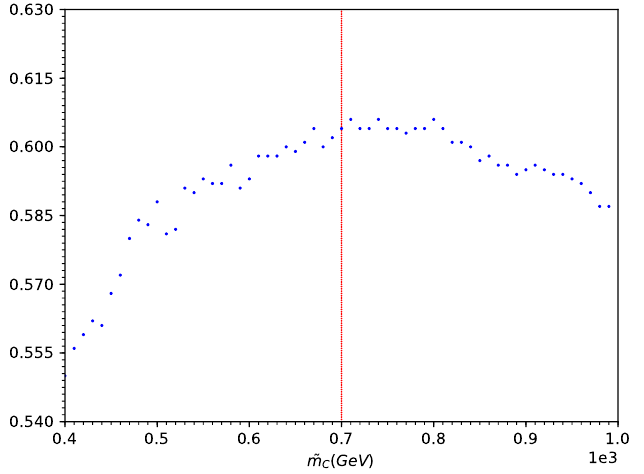
= 400 GeV ( ~ m = 700 GeV, ~ m = 1000 GeV). C C C